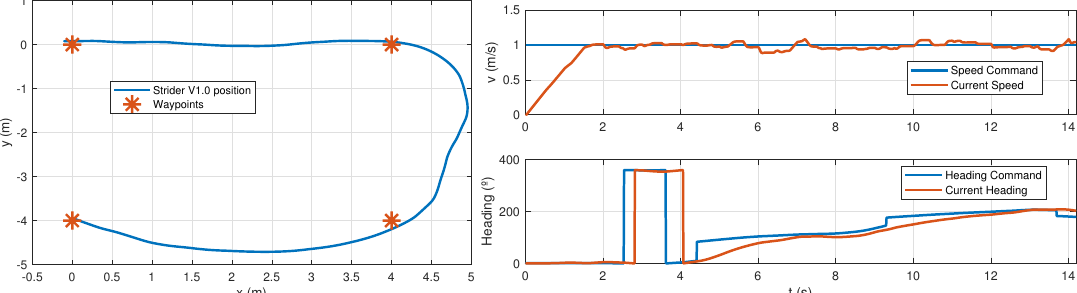
Figure 16. Position of the Strider V1.0 during the U-shaped trajectory test ( left ) and current and commanded speed and heading for the U-shaped trajectory test ( Right ).